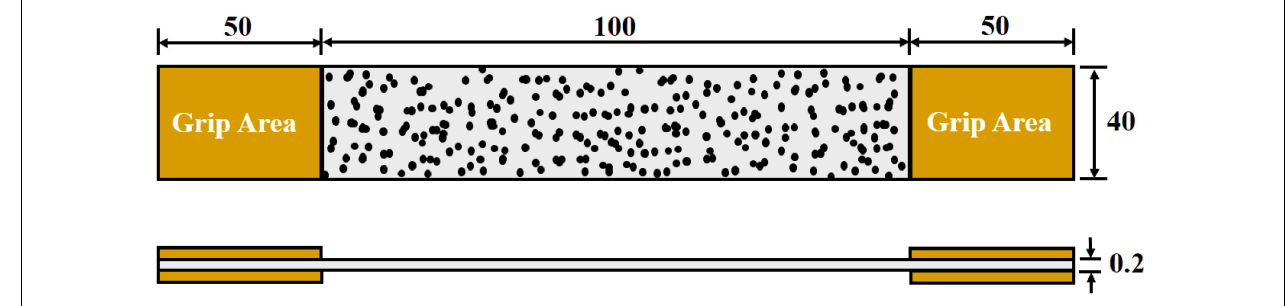
FIGURE 1 | Illustration of dimensions of BC or BCA sample for tensile testing measurement via the 3D-DIC system. All dimensions are in mm. A set of three samples of each BC and BCA composite were prepared for tensile testing